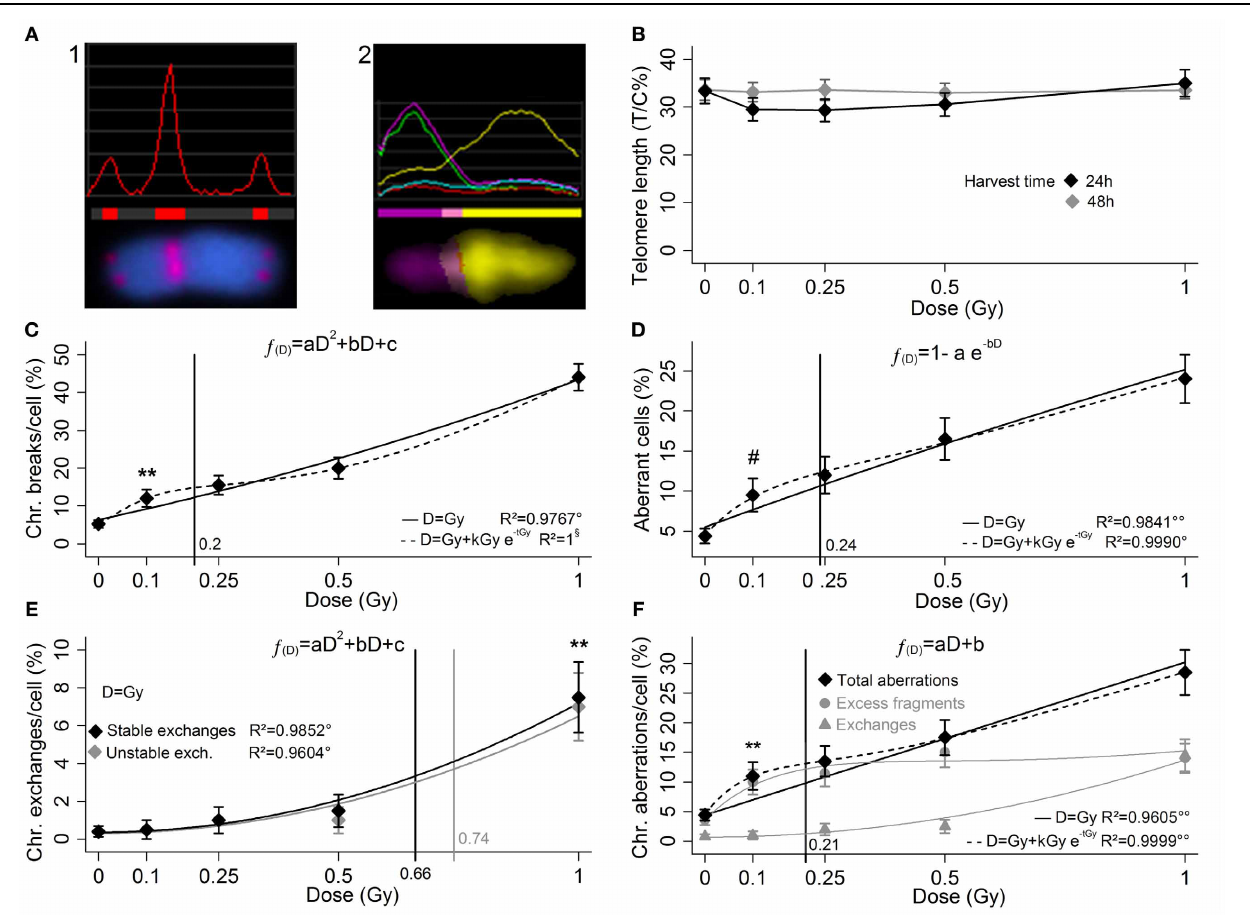
FIGURE 1 | In the q-FISH analysis for telomere length (A1) the telomeric signal is compared to the signal of the chromosome 2 centromere, stained with the same fluorophore. In the m-FISH (A2) each chromosome has a specific multi-fluorophore staining which allows the structural aberrations to be detected all over the karyotype. Here the image analysis of aberrant chromosome (1 (cid:3) 15). (B) Up to 1Gy no telomere length variation is reported 24 and 48h after a low doses of X-rays, and no threshold dose for telomere length variation is determinable. (C) Yield of radio-induced chromosome breaks (LQ fit), (D) aberrant cell fraction (exponential saturation fit), (E) yield of stable and unstable exchanges (LQ fits, black and gray markers